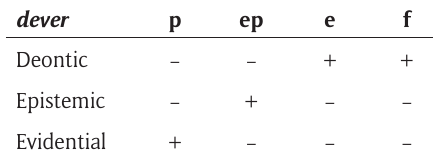
Table 4: Uses of dever